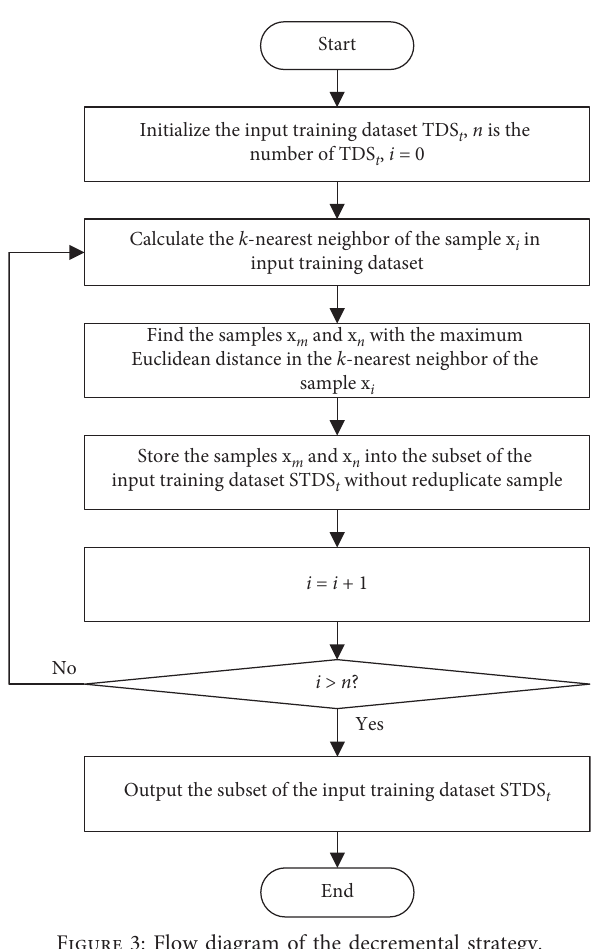
Figure 3: Flow diagram of the decremental